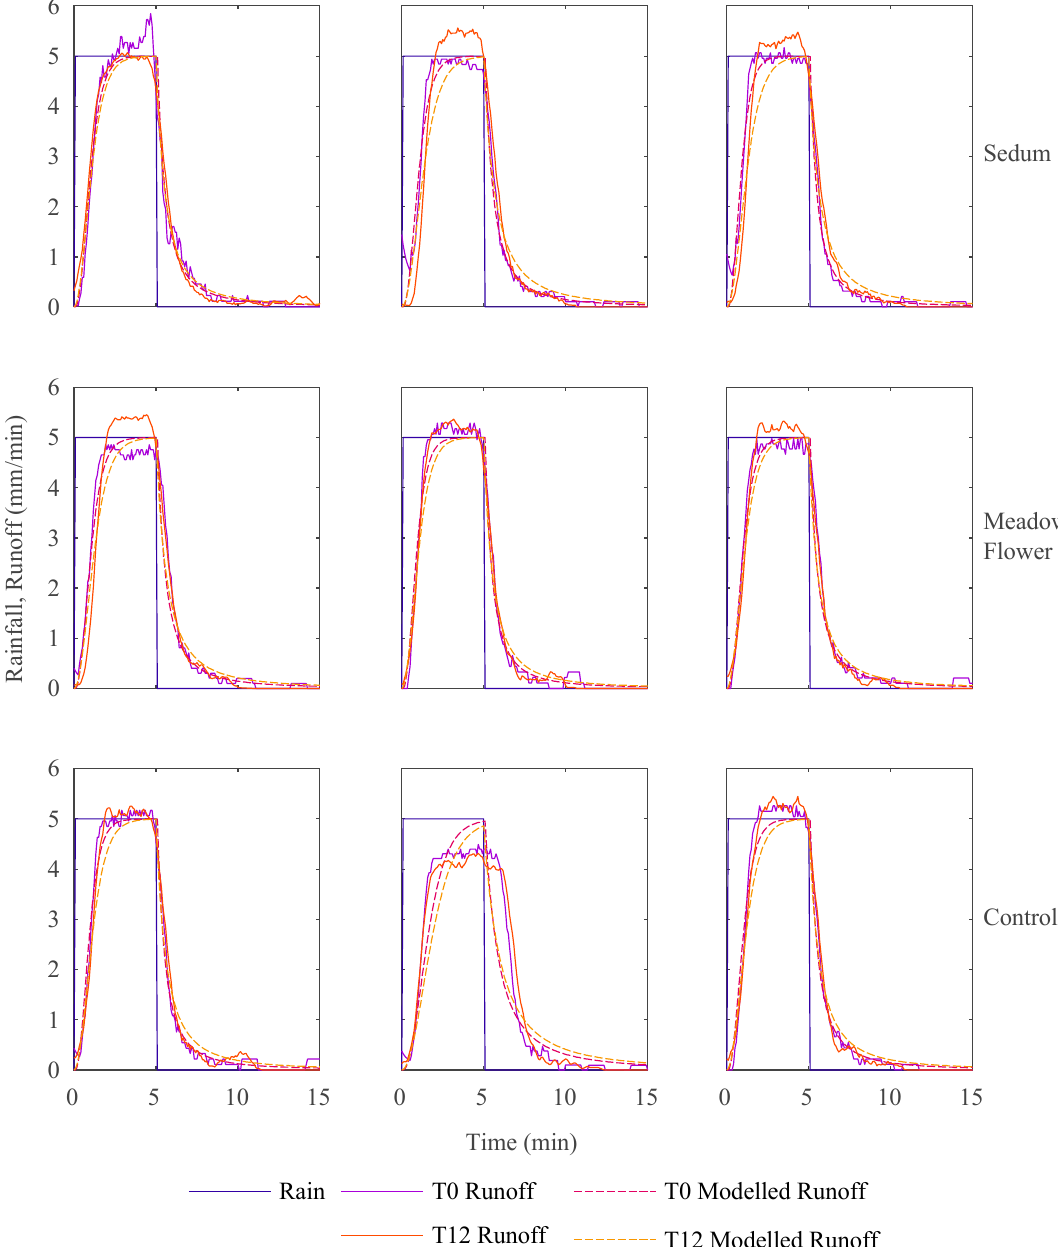
Figure 4. Rainfall and runoff from experimental simulated rainfall events on BBS microcosms, including best fit detention model runoff profiles.